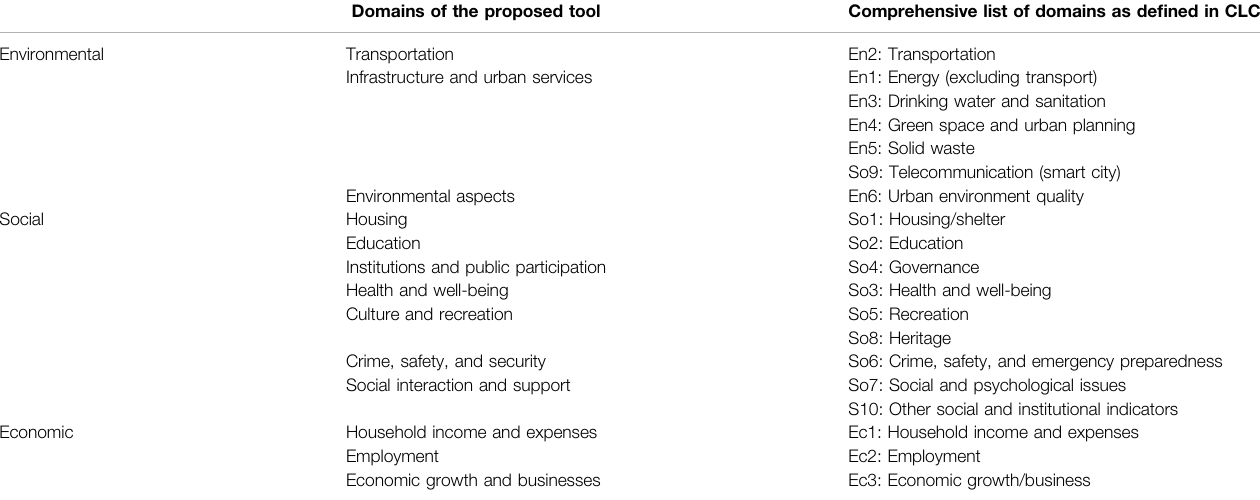
TABLE 8 | Mapping of the 13 selected domains to CLC